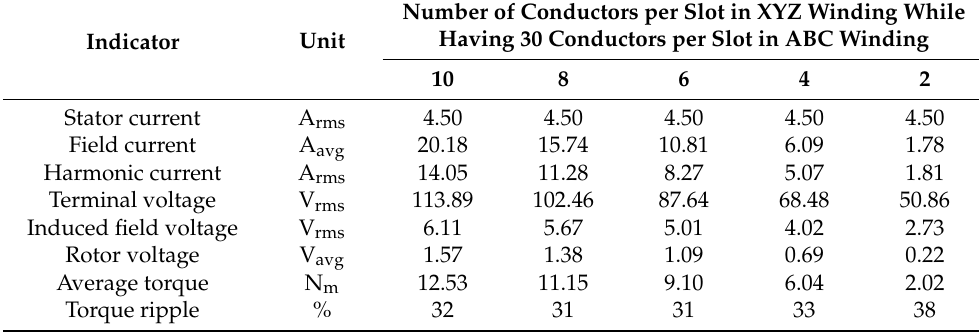
Table 3. Variation in performance of proposed SHSM with different conductors of XYZ